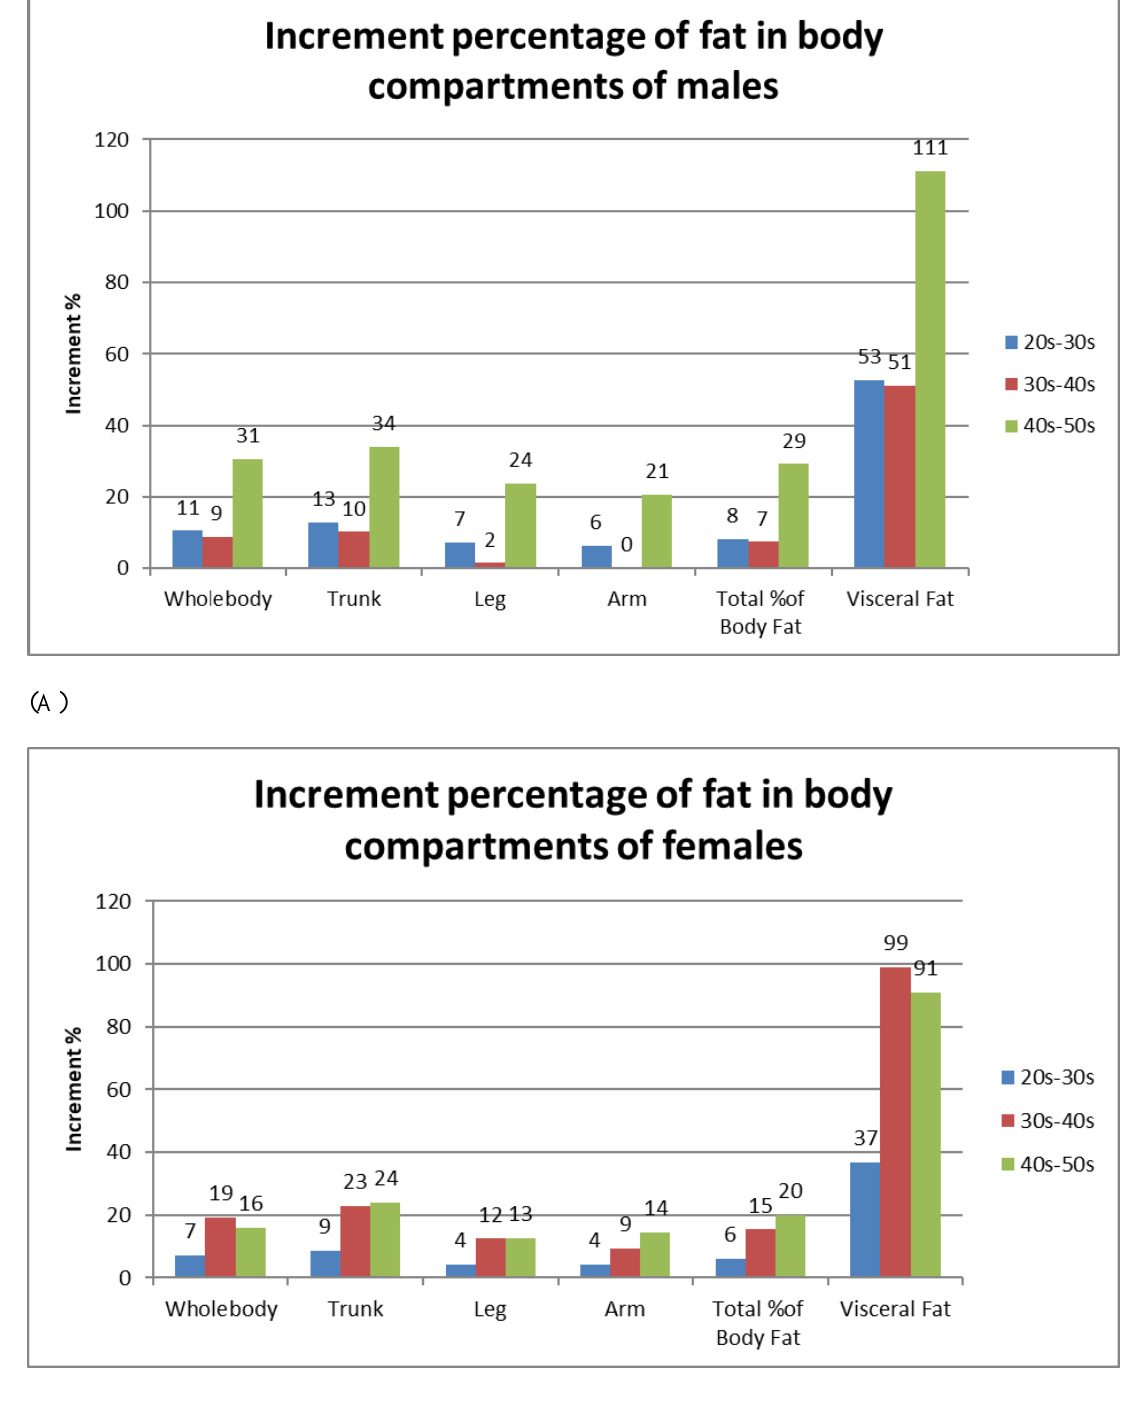
Figure 1 (A) Increment percentages of fat in body compartments of males from 20s to 30s, 30s to 40s and 40s to 50s; (B) Increment percentages of fat in body compartments of females from 20s to 30s, 30s to 40s and 40s to